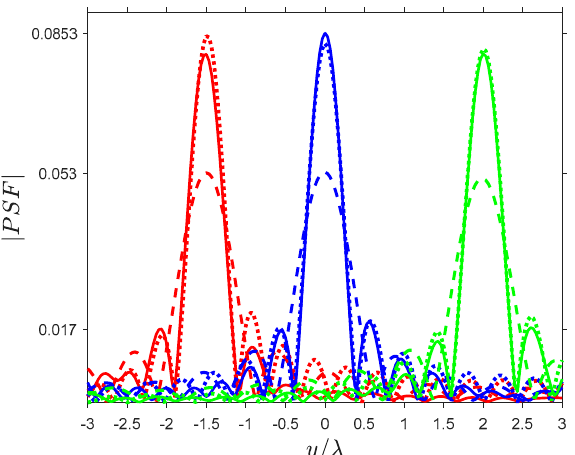
Figure 10. Comparison between the actual PSFs of the left side for x 0 = − 1.5 λ (red lines), x 0 = 0 λ (blue lines), and x 0 = 2 λ (green lines) in reflection mode (solid lines), transmission mode (dotted lines), and angle mode (dashed lines).